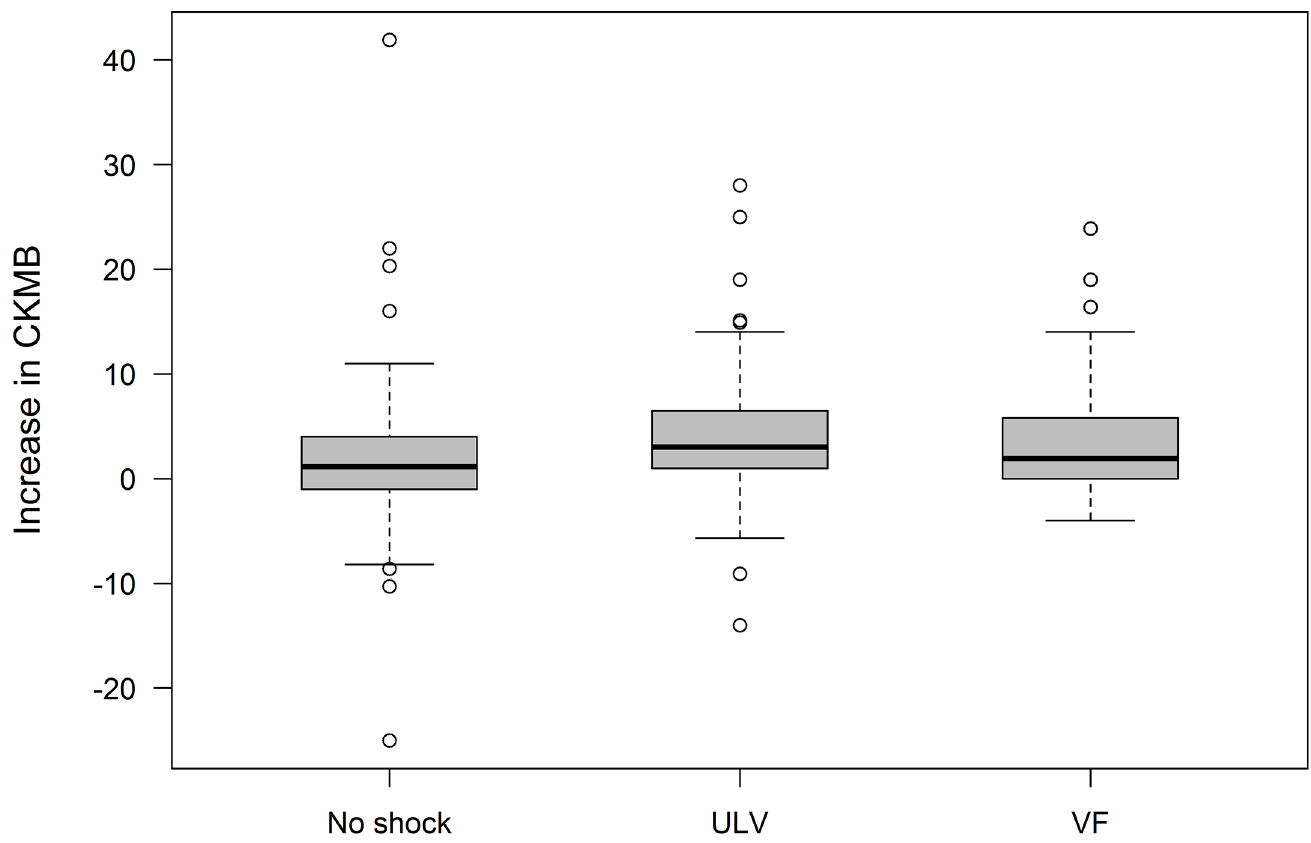
Fig 4. Secondary endpoint; increase in CK-MB[U/l] (intention-to-treat) for all randomization groups. CK-MB = Creatinkinase MB, No Shock = Implantation without ICD testing, ULV = Upper Limit of Vulnerability Testing, VF = Induction of Ventricular Fibrillation (traditional safety margin